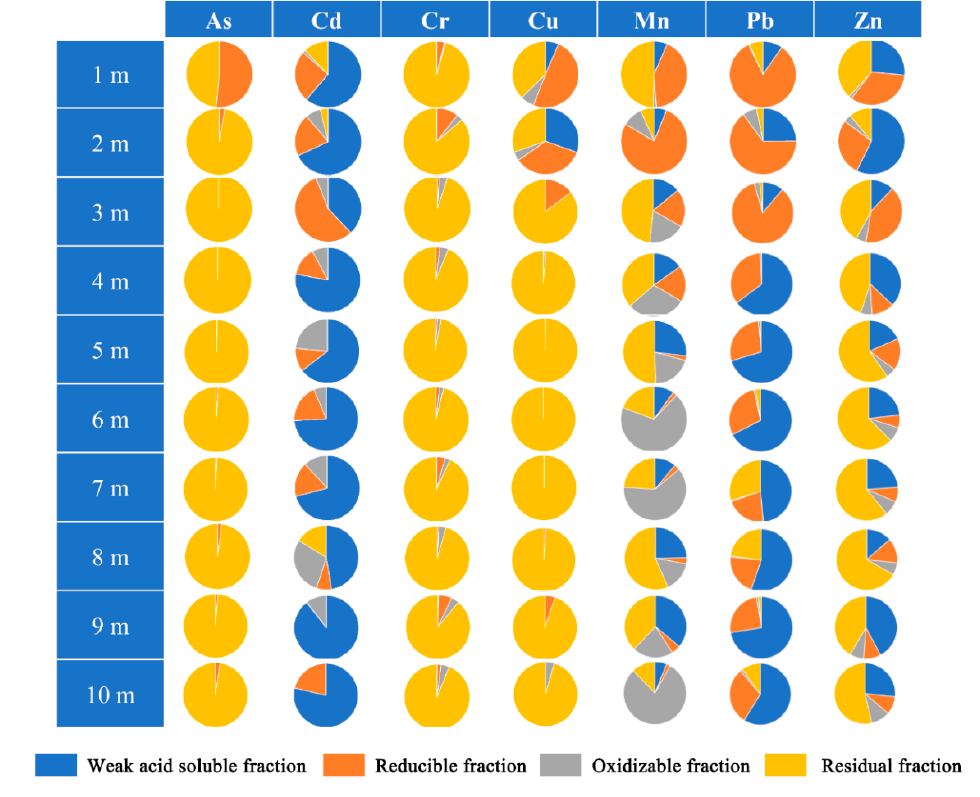
Figure 3. Compositions of four fractions for each metal(loid) in different soil depths.